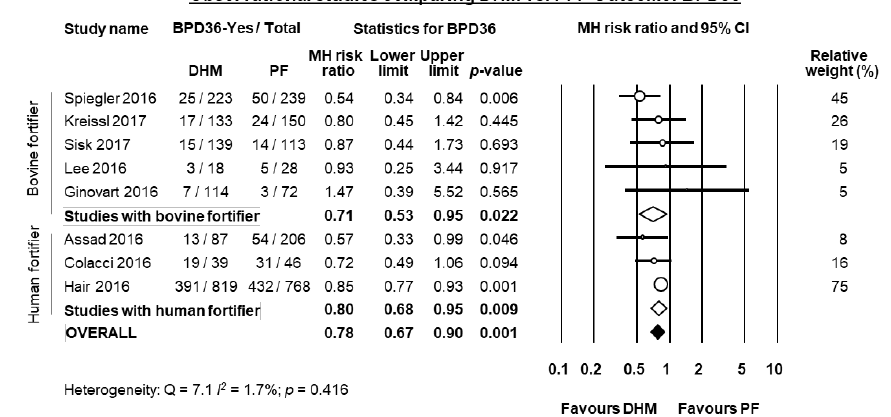
Figure 4. Meta-analysis of observational studies assessing the effects of supplementation of MOM with DHM, compared with supplementation with PF, on risk of BPD36. Circles (O) represent the effect sizes per study, and their size represents the relative weight of the study in the meta-analysis. Diamonds ( ◆ ) represent the pooled effect size. DHM: donor human milk; PF: preterm formula; BPD36: bronchopulmonary dysplasia defined as oxygen depenency at 36 weeks post-menstrual age; MH: Mantel-Haenszel.